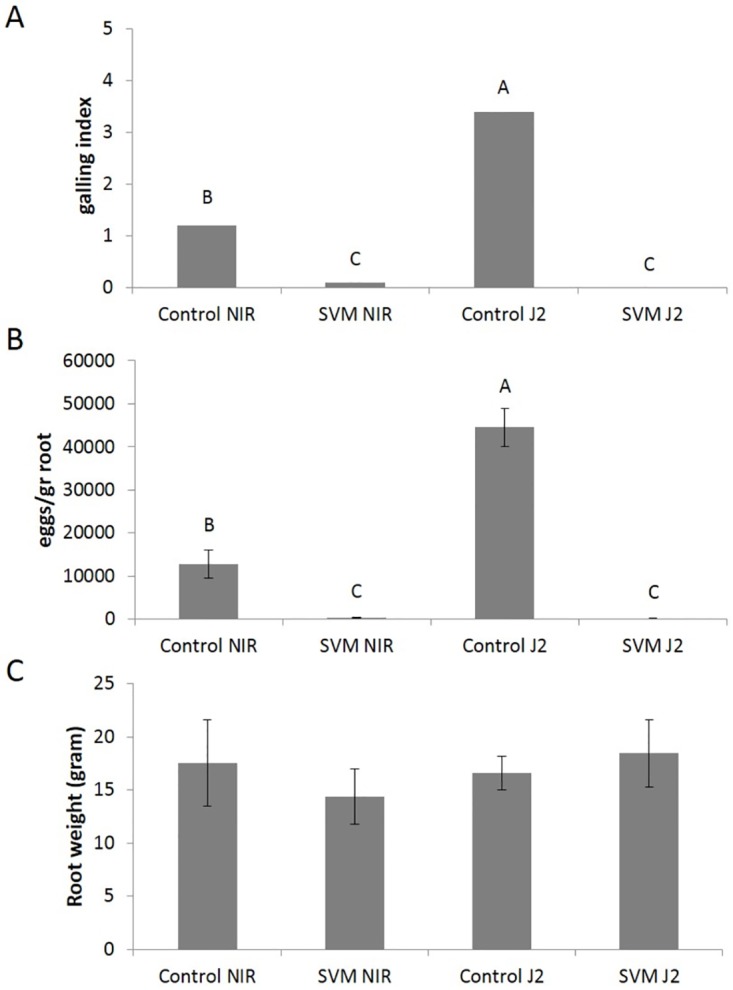
Effects of the SVM in greenhouse experiments.Susceptible tomato seedlings were planted in inoculated soil, with or without pretreatment with the synthetic volatile mixture (SVM). Four treatments were designated: Control NIR—soil inoculated with nematode-infected roots (NIR) infested by M. javanica in amounts equivalent to 4,000 eggs in root suspension in each pot; SVM NIR—soil inoculated with nematode-infected roots infested by M. javanica in amounts equivalent to 4,000 eggs in root suspension in each pot and supplemented with the synthetic volatile mixture; Control J2 –soil inoculated by direct insertion of 4,000 M. javanica J2s into each pot; and SVM J2 –soil inoculated by direct insertion of 4,000 M. javanica J2s and supplemented with the synthetic volatile mixture. (A) Galling index (mean of five repetitions). The results were subjected to nonparametric comparison using Wilcoxon method; different letters above the bars indicate a significant difference between samples significant at P ≤ 0.05. (B) Mean numbers (± SE) of M. javanica eggs per gram of root. The results were subjected to analysis of variance followed by the Tukey-Kramer multiple comparison test; different letters above the bars indicate a significant difference between samples at P ≤ 0.05. (C) Mean weights (± SE) of tomatoes roots. The results were subjected to analysis of variance. No significant differences (P > 0.01) between treatments in root weight were found. The experiment was independently repeated twice, each time with similar results.